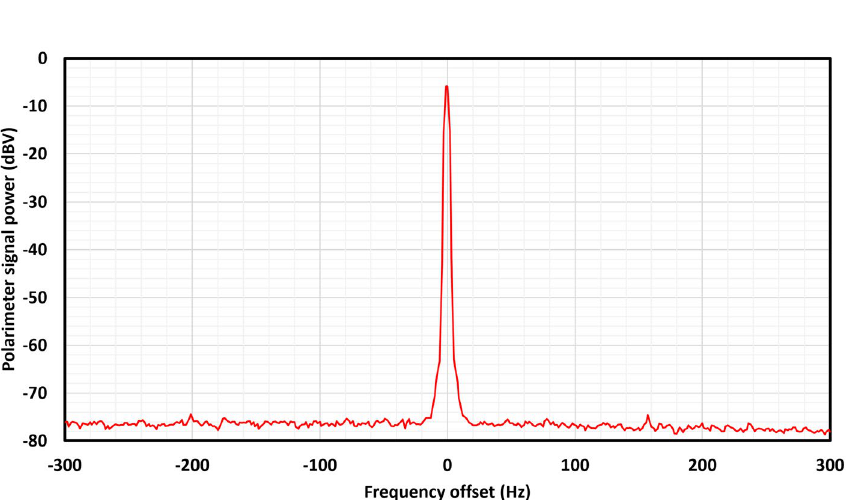
Figure 3. Spectrum of digital spin maser signal around resonance in the presence of a static B 0 field of 50 µ T , acquired using a Picoscope 5444D oscilloscope (15-bit, 200 MHz bandwidth down-sampled to 200 kHz, 2 17 samples, 32 averages, Blackman windowed). Peak power 70 dB above a white noise floor can be seen, giving a 1 2 signal-to-noise-density ratio of A /ρ = 3162Hz